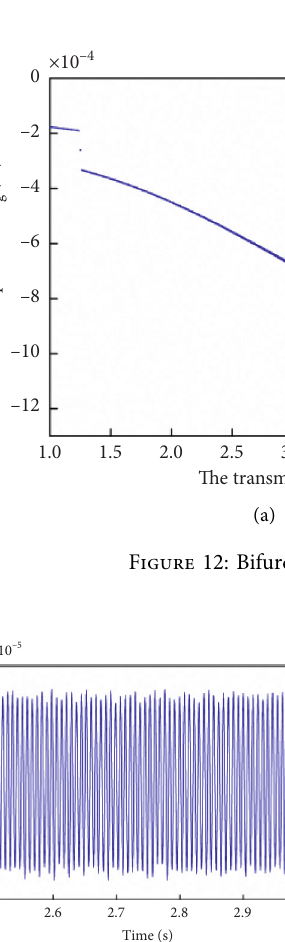
� 1.25. (a) Time-domain diagram. (b) Frequency-domain diagram. (c) Poincare map. p at i